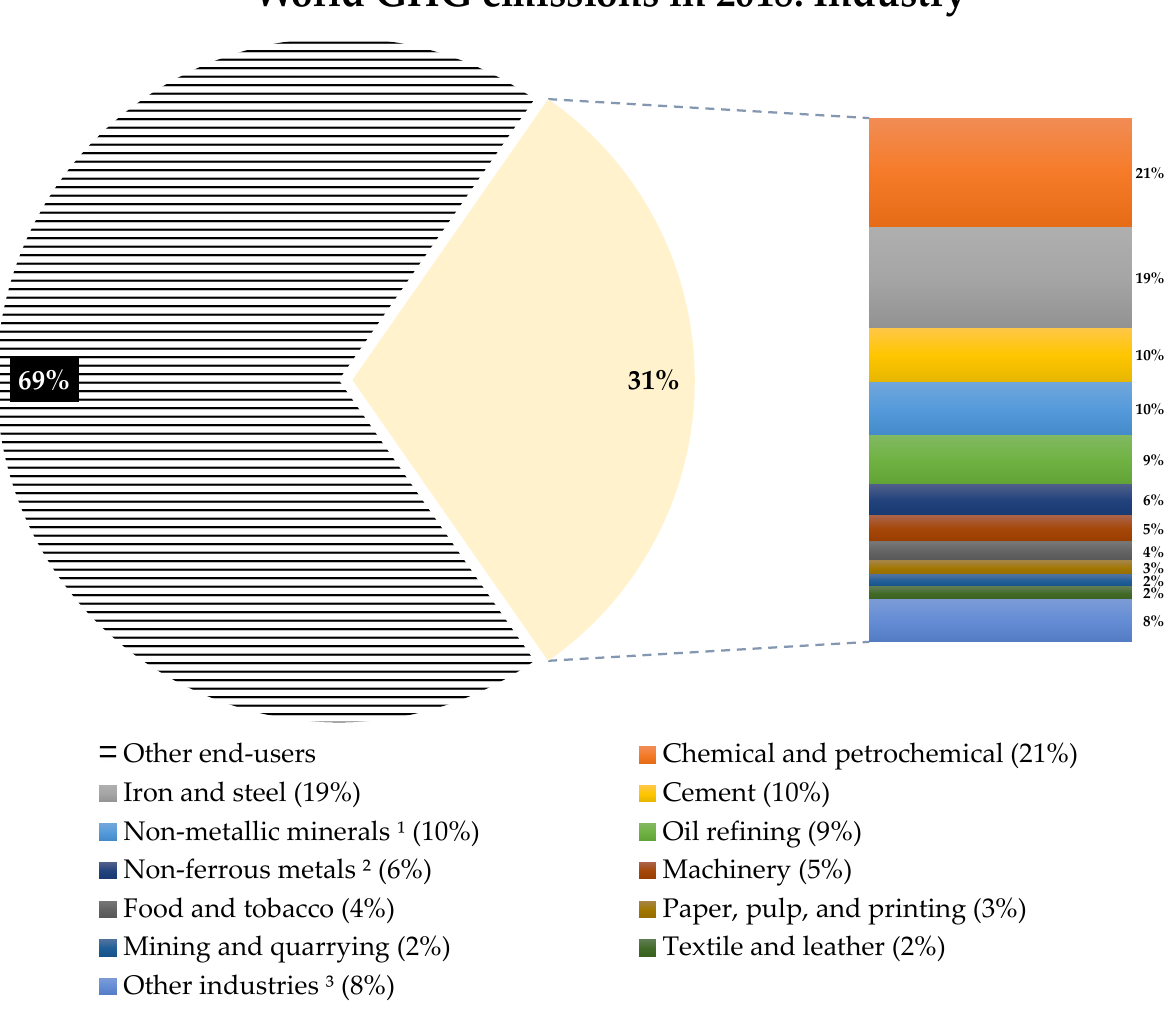
Figure 1. Focus on the share of global GHG emissions of the industry sector (2018). 1 E.g., lime, glass, and ceramics. 2 E.g., aluminum and magnesium. 3 Includes Transport equipment, Wood industry and products, Electronics. Data from [3,7,8,13,14].